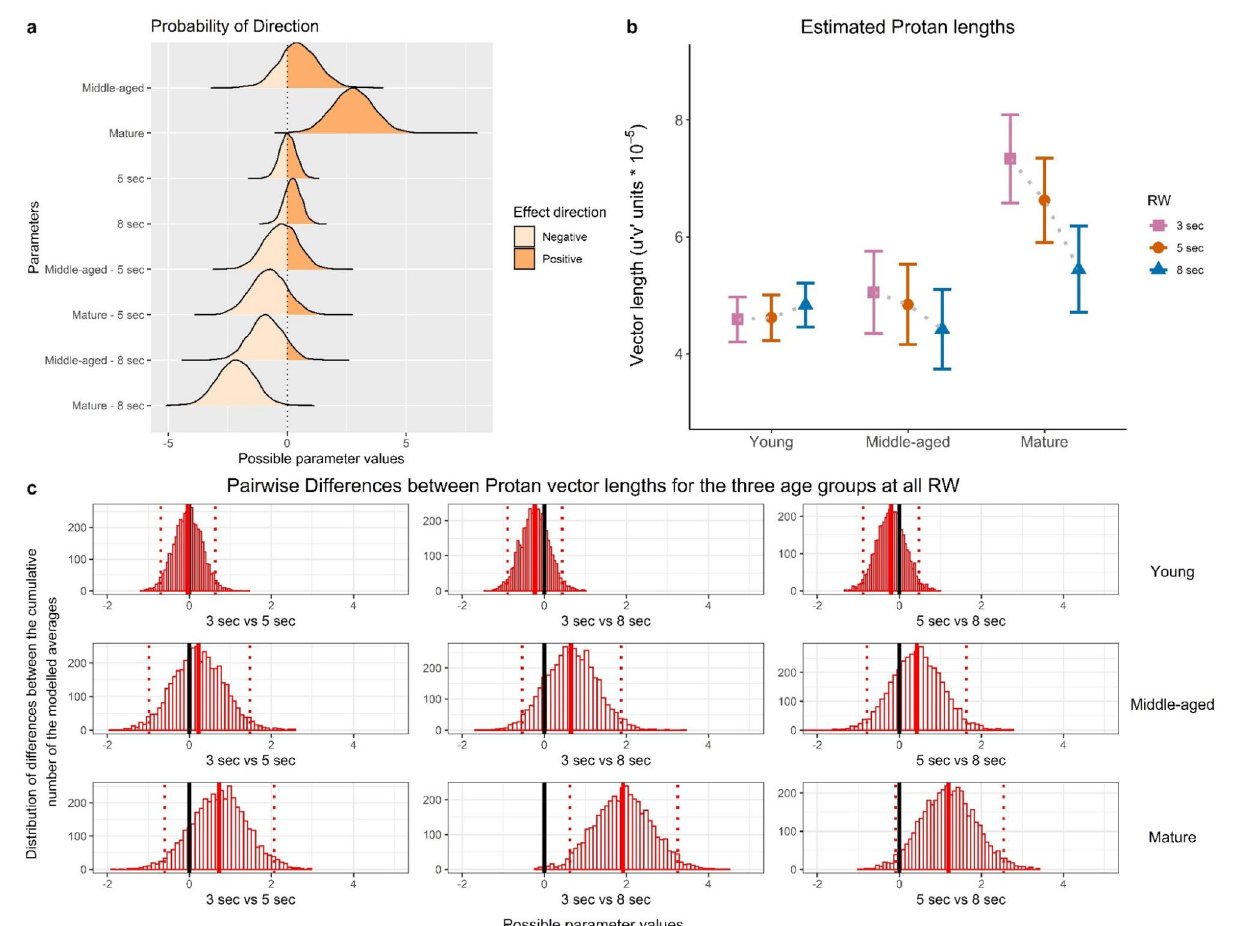
Figure 3. Protan measures. Outcomes of the Bayesian model of analysis showing the effect of the response window (RW) for ‘young’, ‘middle-aged’ and ‘mature’ observers. ( a ) The Probability of direction (Pd), positive or negative, of each of the model parameters. Parameters are compared to their references: ‘middle-aged’ and ‘mature’ groups are compared to the ‘young’ group, 5-s and 8-s RWs are compared to 3-s RW etc. Positive direction indicates higher values and negative direction lower values compared to the reference group. ( b ) Estimated vector length (mean and 95% CI) based on the posterior fit of the Bayesian model. ( c ) Pairwise differences of the estimated lengths for each of the age groups between the three RWs (3 s, 5 s, 8 s). Distributions of the modelled average differences were generated by substracting vector length at a longer RW from that at a shorter RW, whereby a positive distribution indicates greater vector lengths at the shorter RW. The distribution mean is indicated by thick red line, and the uncertainty interval (2.5–97.5%) by dashed lines; where the uncertainty interval does not contain 0 (thick black line), the difference between the two measure distributions indicates that the alternative hypothesis is to be